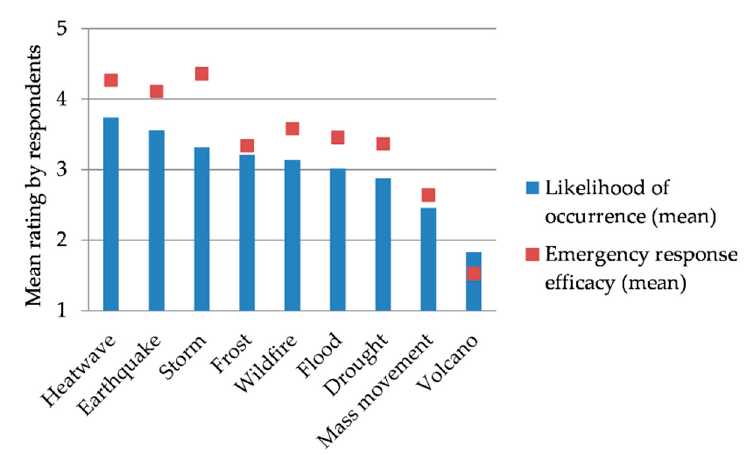
Figure 6. Comparison of mean rating (on a 1–5 scale) of perceived emergency-response efficacy and likelihood of occurrence, across all hazard types.